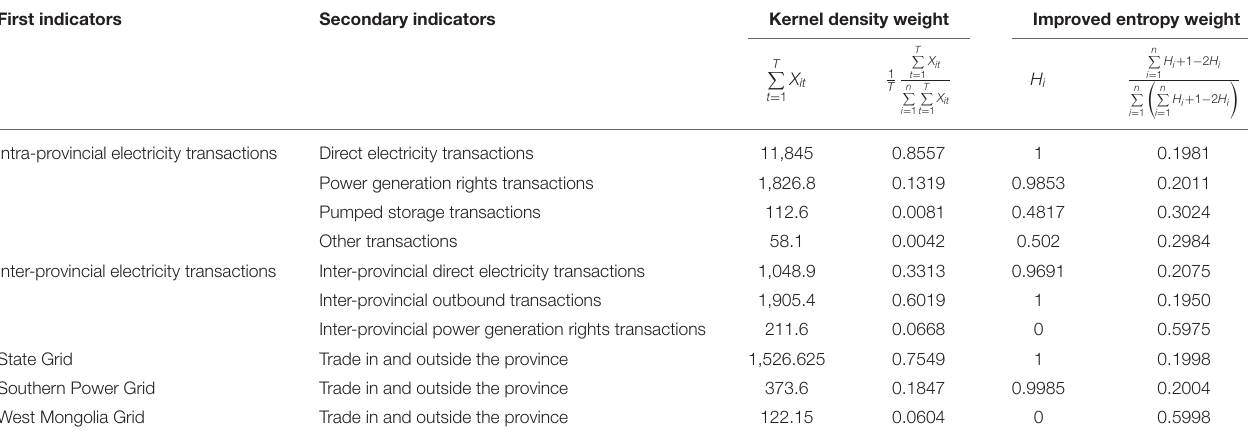
TABLE 3 | The calculation process of kernel density weight and improved entropy weight of different transaction types. First indicators Secondary indicators Kernel density weight Improved entropy